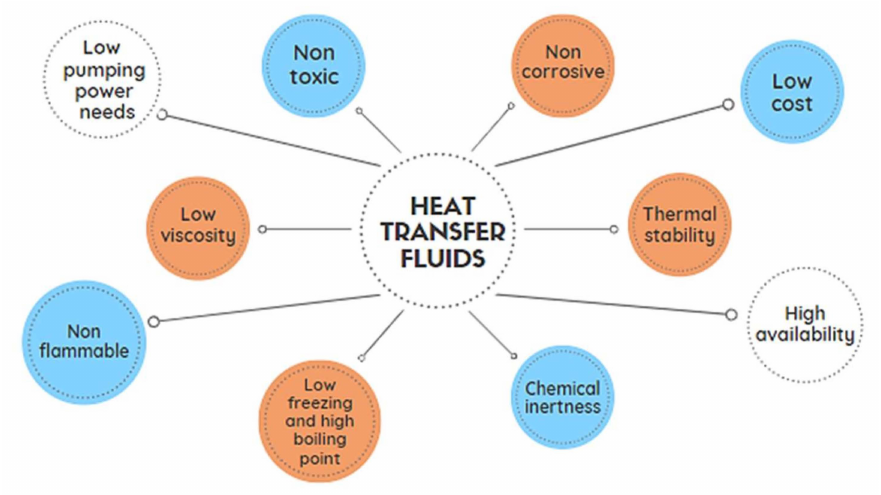
Figure 1. Characteristics of the ideal